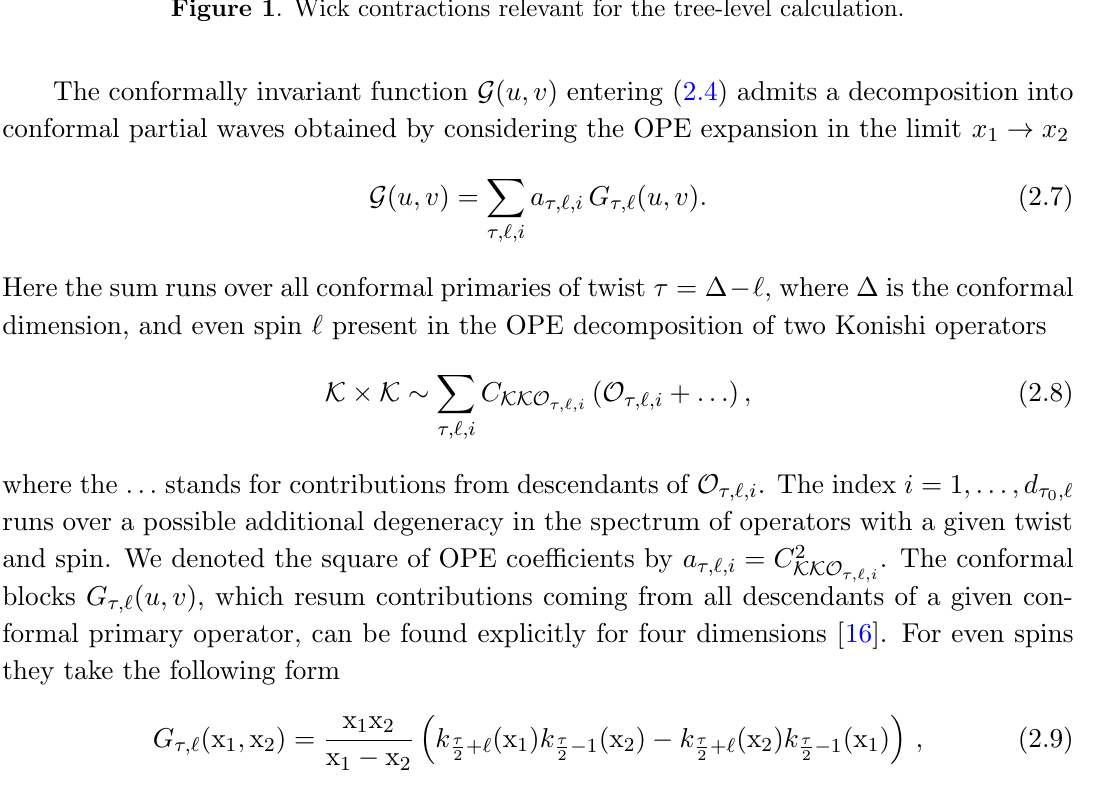
Figure 1 . Wick contractions relevant for the tree-level